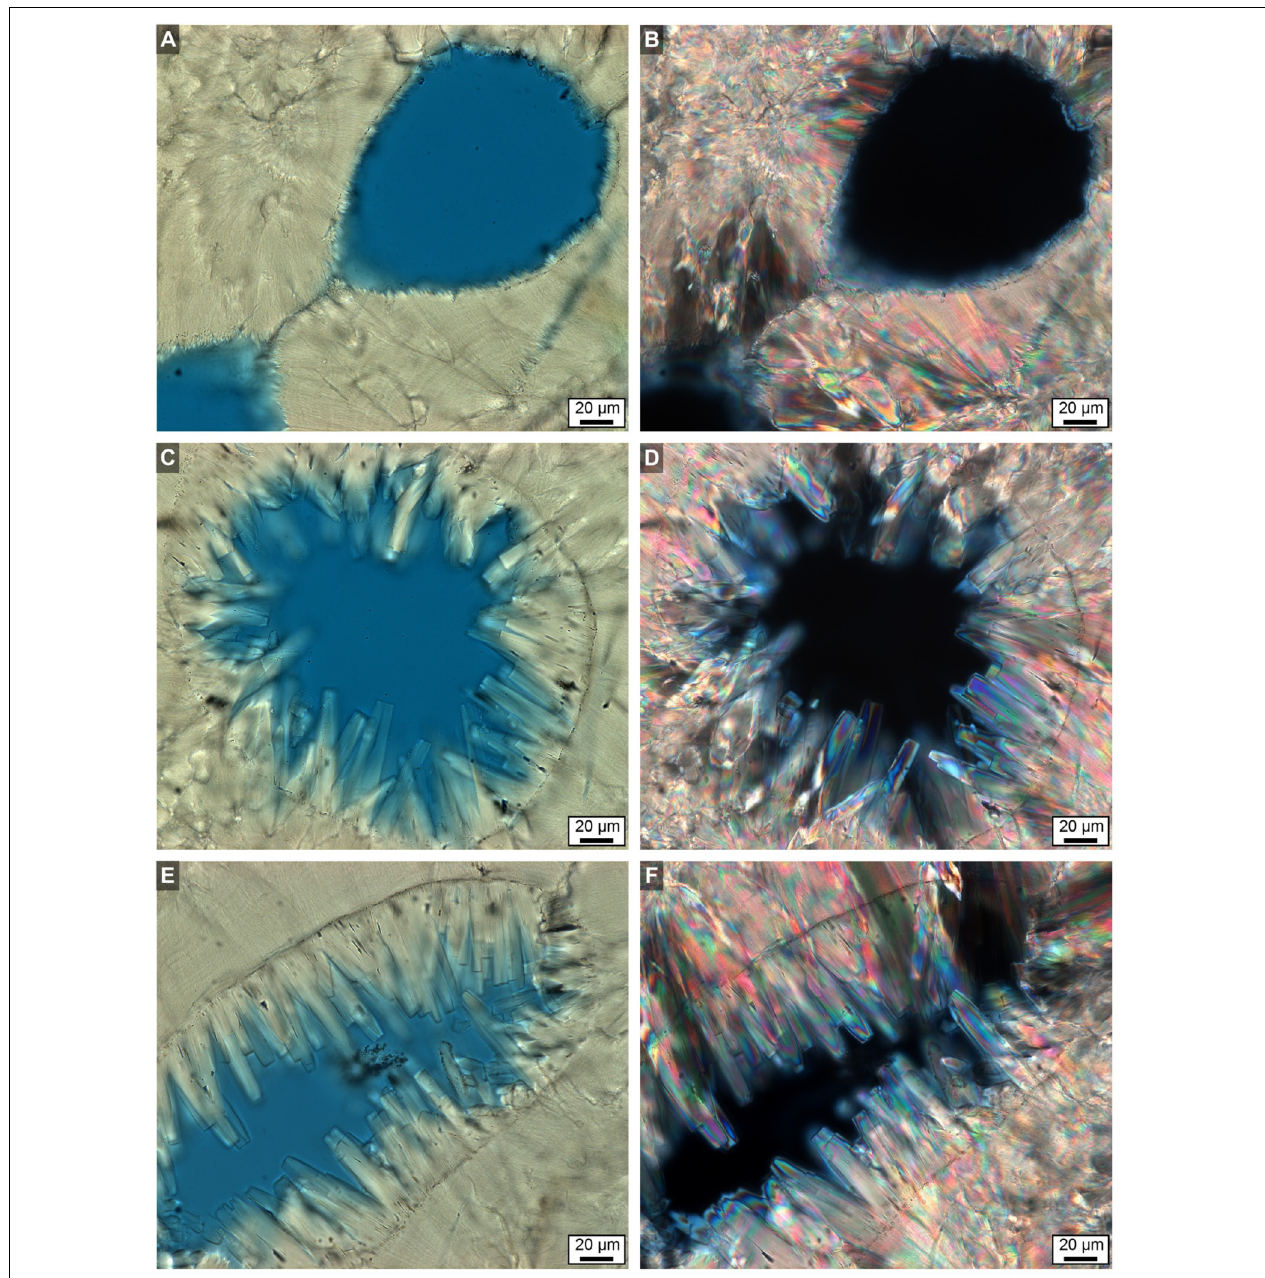
FIGURE 14 | Brightfield (BF) and polarization (POL) images showing extensive diagenetic aragonite cement occluding high- and low-density band (HDB and LDB) pore space in the bottom 6 cm of Core 3. (A,C,E) BF images. (B,D,F) Corresponding POL images. Original pore margins are clearly visible in all images. Diagenetic aragonite cement exhibits both sharp and blunt crystal terminations. Images (A,B) are from a LDB, while images (C–F) are from HDBs.